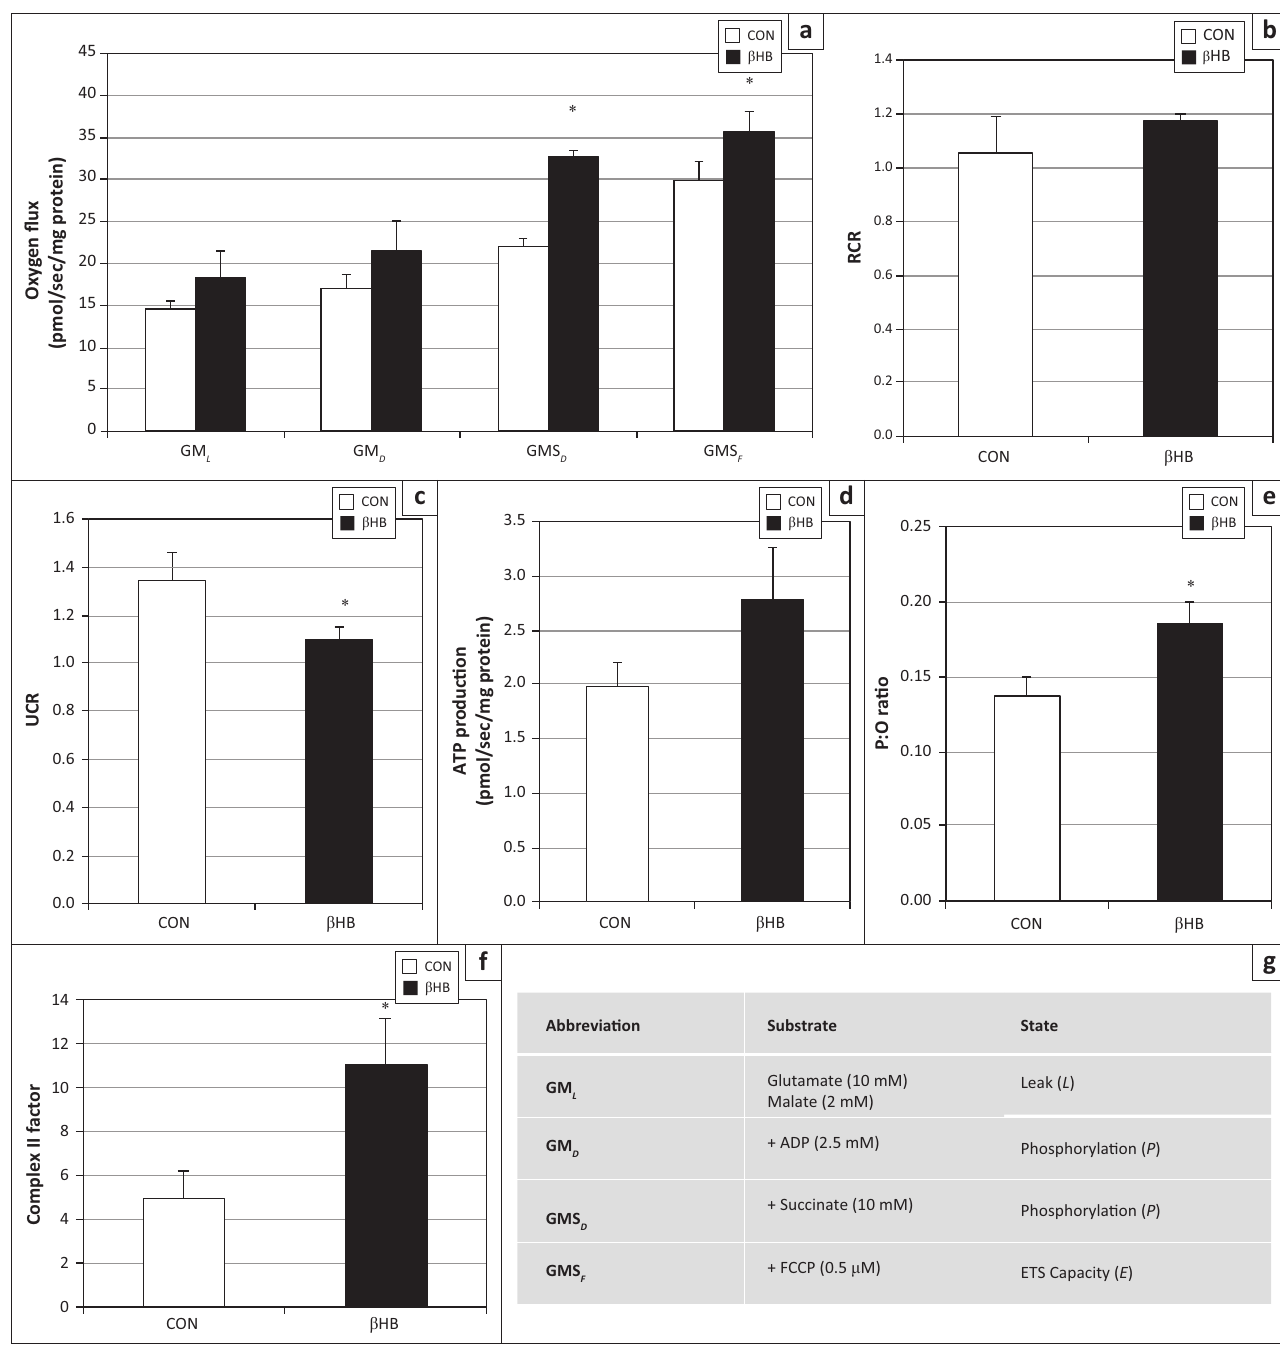
FIGURE 3: β -Hydroxybutyrate favourably alters mitochondrial function. INS-1 832/13 β -cells were treated with vehicle (water; CON) or with β -Hydroxybutyrate ( β HB; 10 mM) for 24 h. To measure mitochondrial respiration (a; n = 6), cells were treated with GM L : glutamate (10 mM) + malate (2 mM); GM D : + ADP (2.5 mM); GMS D : + succinate (10 mM); GMS F : + FCCP (0.05 μ M) [details in (g)]. Respiratory control ratio (b; RCR; GM factor (f; GMS -GM ) were determined from the respiration assay. ATP production (d) and P:O ratio (e; peak ATP production/O D D by measuring fluorescence (503 mM/530 mM) with MgG. * P < 0.05; n = 6. and β -cell insulin production. Concomitant with these improvements, hepatic and pancreatic fat significantly diminished. However, the ability of lifestyle changes to promote β -cell ‘recovery’ is not universal. By introducing lifestyle changes, including alterations in nutrient content to reduce carbohydrate consumption among patients, McFarlane et al. 7 found that roughly half achieved a complete remission of T2D, including a normalisation of β -cell function. Despite